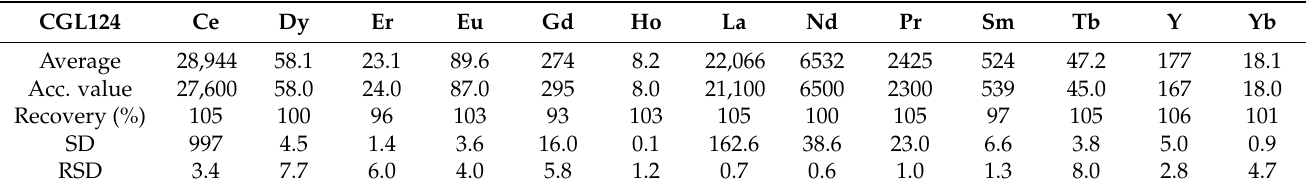
Performance of the developed method on CGL124 analysis in terms of accuracy and precision.